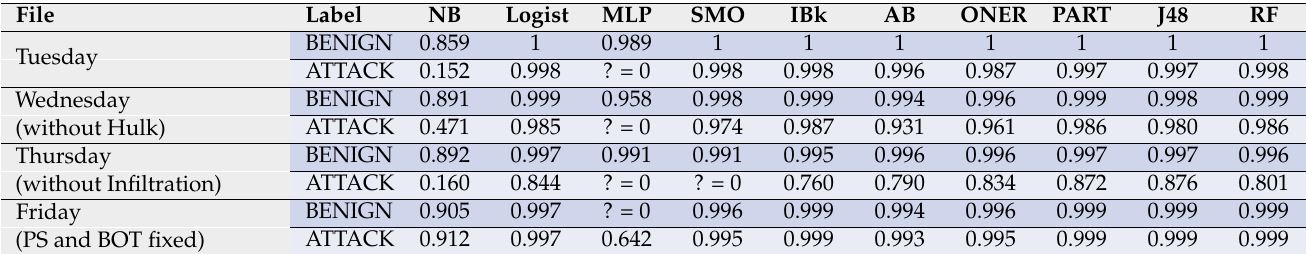
Table 18. F1 performance results using Zeek derived flows and attributes.